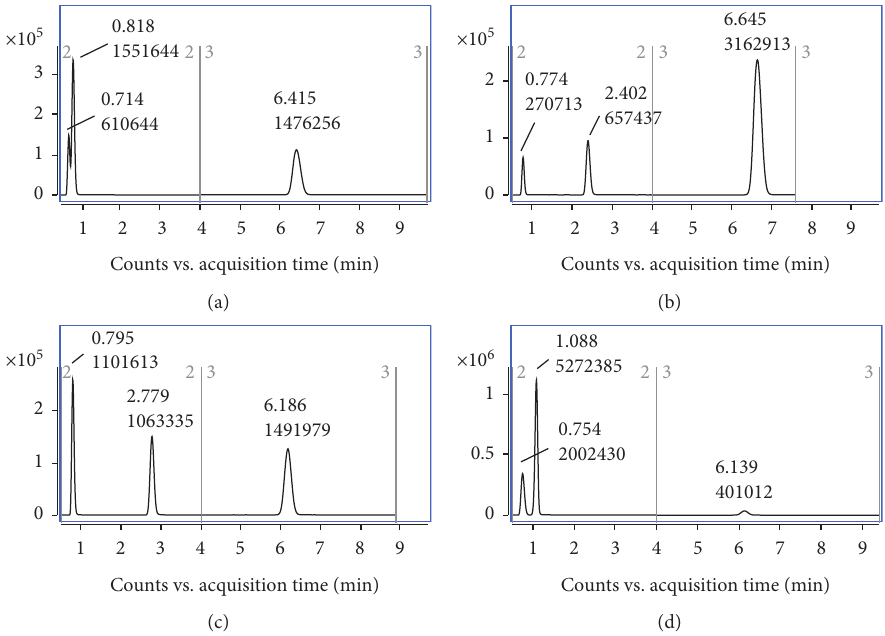
Figure 2: HPLC-MS/MS chromatograms of DFA (1.0mg/L), 6-CNA (1.0mg/L) and flupyradifurone (0.1mg/L) on C same elution procedure under different mobile phase conditions. ((a) 5mmol ammonium acetate aqueous solution/acetonitrile, (b) 0.1% formic acid and 5mmol ammonium acetate aqueous solution/acetonitrile, (c) 0.1% formic acid aqueous solution/acetonitrile, (d) water/ acetonitrile).